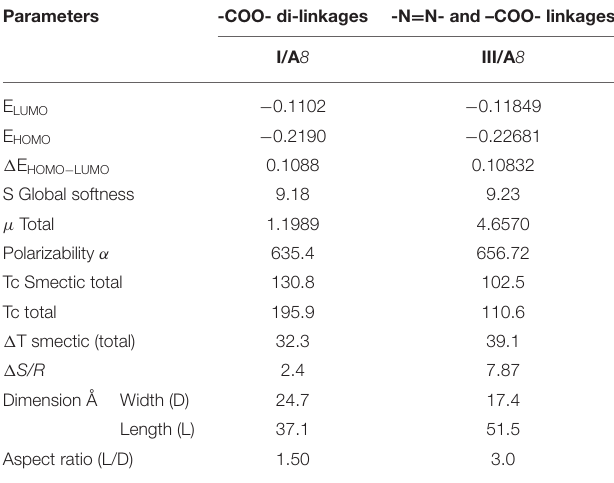
TABLE 5 | FMO energies a.u., polarizability, α , and dipole moment µ (Debye) of SMHBCs, (I, III)/A 8 .